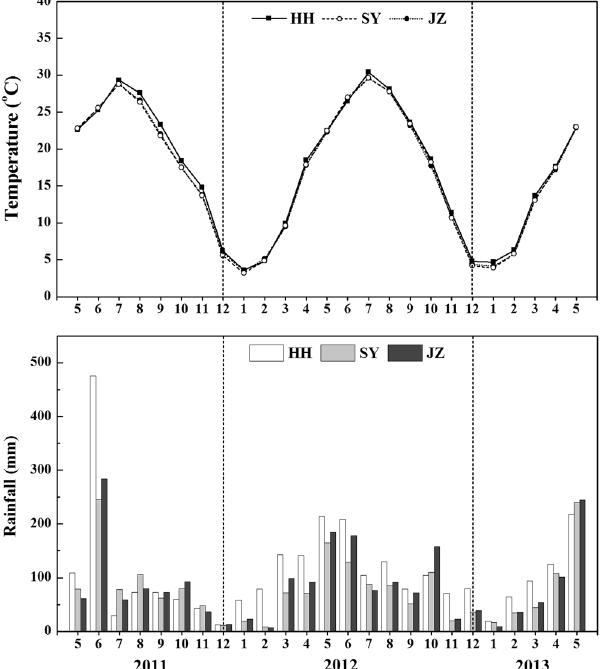
Figure 4. Monthly total rainfall and monthly mean temperature during the crops growth season at the experimental sites in Hubei province of China. HH, SY and JZ represent Honghu, Shayang and Jingzhou